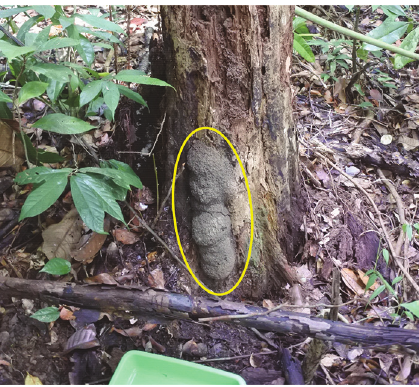
Figure 3: A nest of Termes propinquus attached to a stump, in a diptercarp forest of Suaq Balimbing, North Sumatra (Suaq Balimbing Field Station; colony (SUAQ-TT-2017-C012).